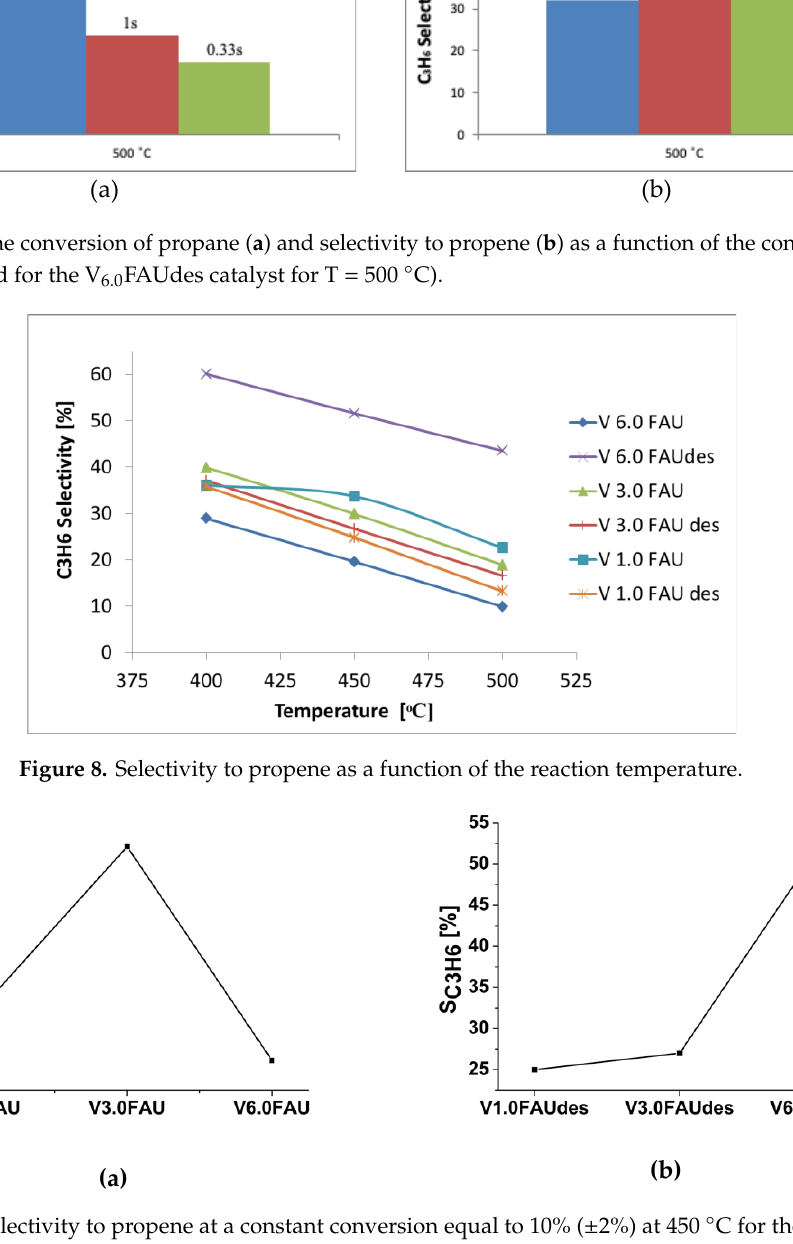
Figure 9. Selectivity to propene at a constant conversion equal to 10% (±2%) at 450 °C for the V x FAU (a) and at constant conversion equal to 5% at 450 °C for the V x FAUdes (b) series. The direct comparison of the catalytic activity (i.e., the selectivity to C 3 H 6 ) within each of the series can be done only at the constant conversion regimes. As the reference conditions, the conversion of 10% (±2%) at 450 °C was chosen for the V x FAU series — see Figure 9a. It seems that the best activity is achieved for the V 3.0 FAU sample. The selectivity to propene reached 37.5%. As can be noticed, the samples of both lower and higher vanadium loading exhibit a lower selectivity to propene. The V 3.0 FAU catalyst is characterized by the lowest total acidity from the series. For the V x FAUdes series, the conversion of 5% at 450 °C was chosen (see Figure 9b), as these samples exhibit lower conversions, and 10% conversion is difficult to acquire for all the V x FAUdes catalysts in this temperature. Here, the selectivity to propene increases with the increasing vanadium content. The